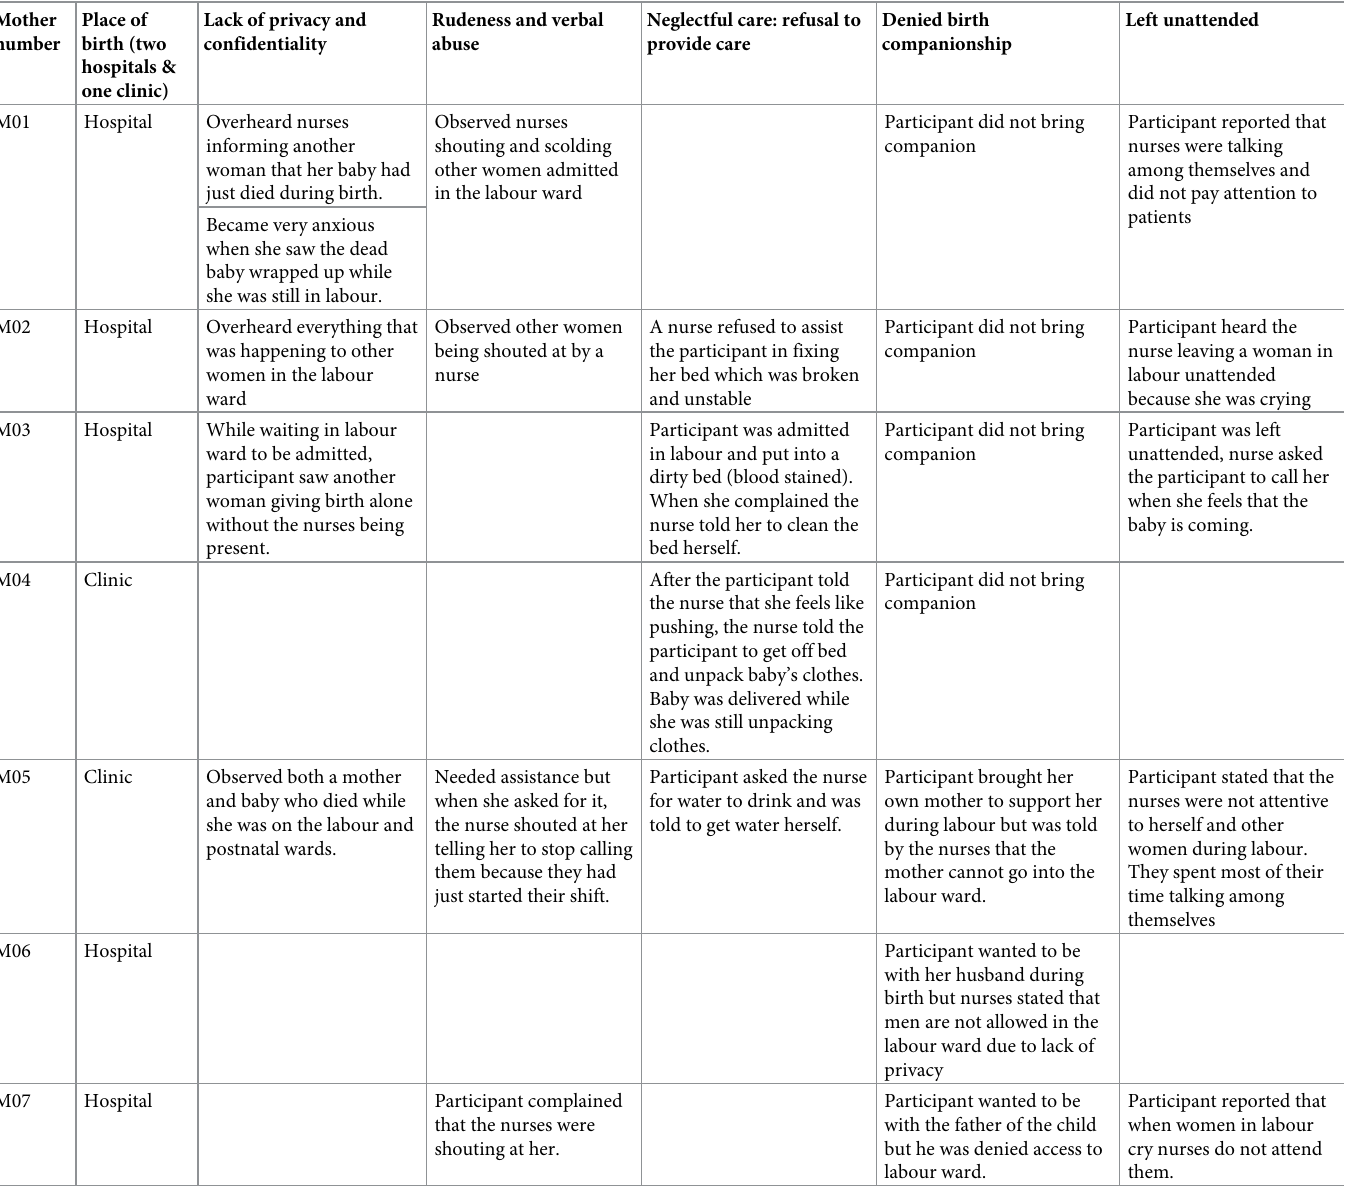
Table 2. Summary of stories of disrespect and abusive care experienced by participants. Mother Place of number birth